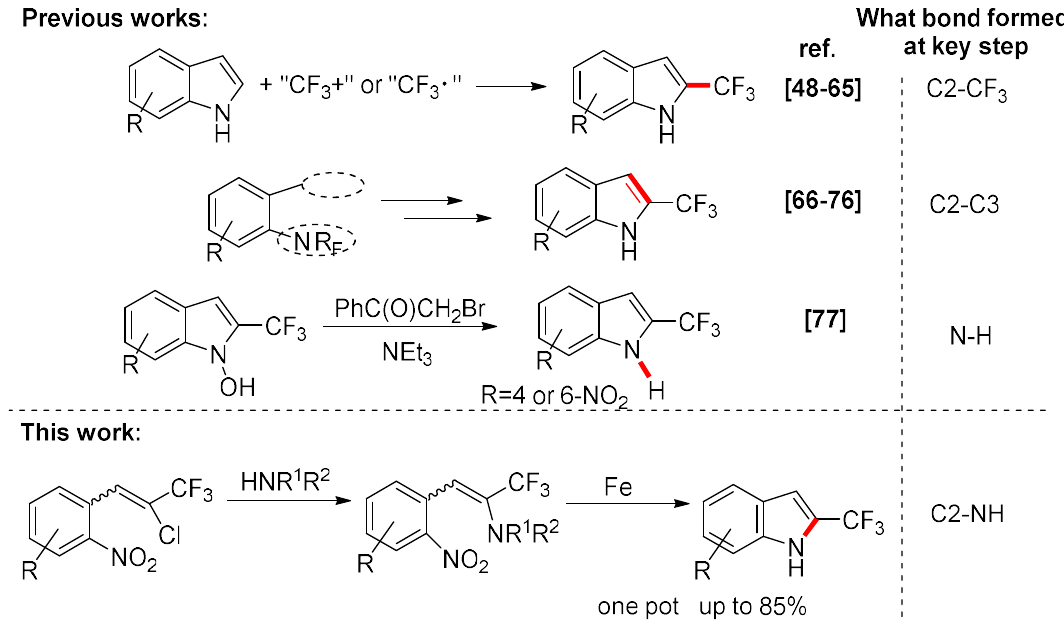
Figure 2. Approaches to 2-CF 3 -indoles having free nitrogen atom and 3-position.